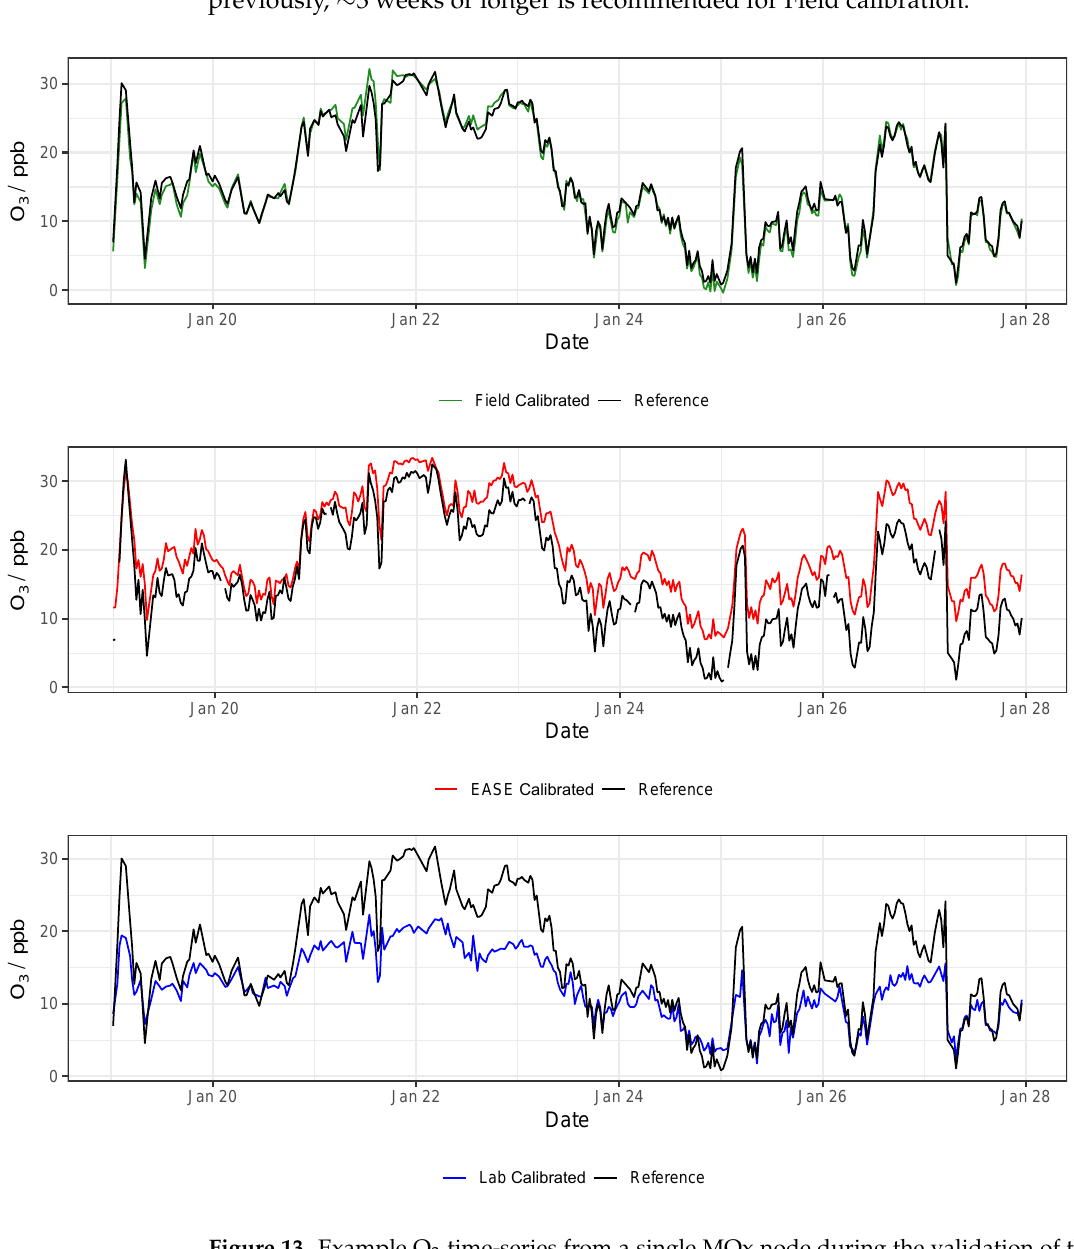
Figure 13. Example O 3 time-series from a single MOx node during the validation of the different calibration methods, compared with data from the reference instrument. Lab is short for